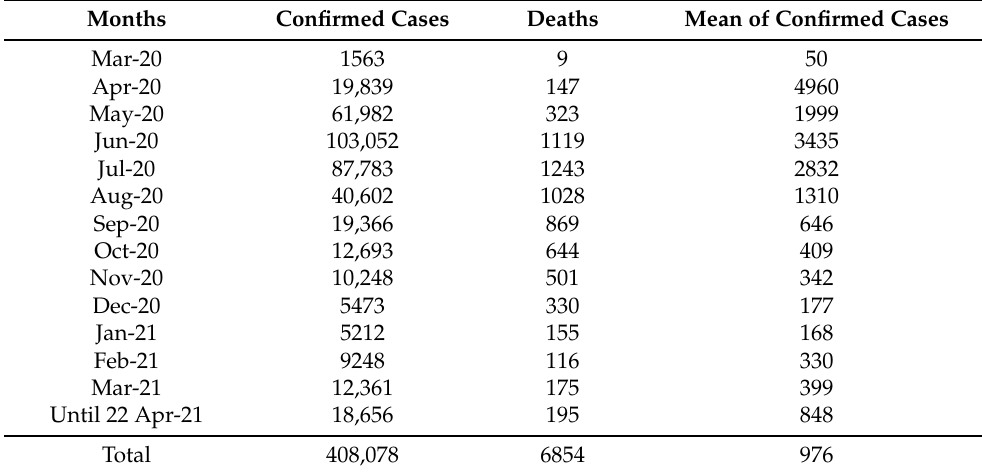
Table 1. Summary of the total number of the confirmed cases and deaths in Saudi Arabia.